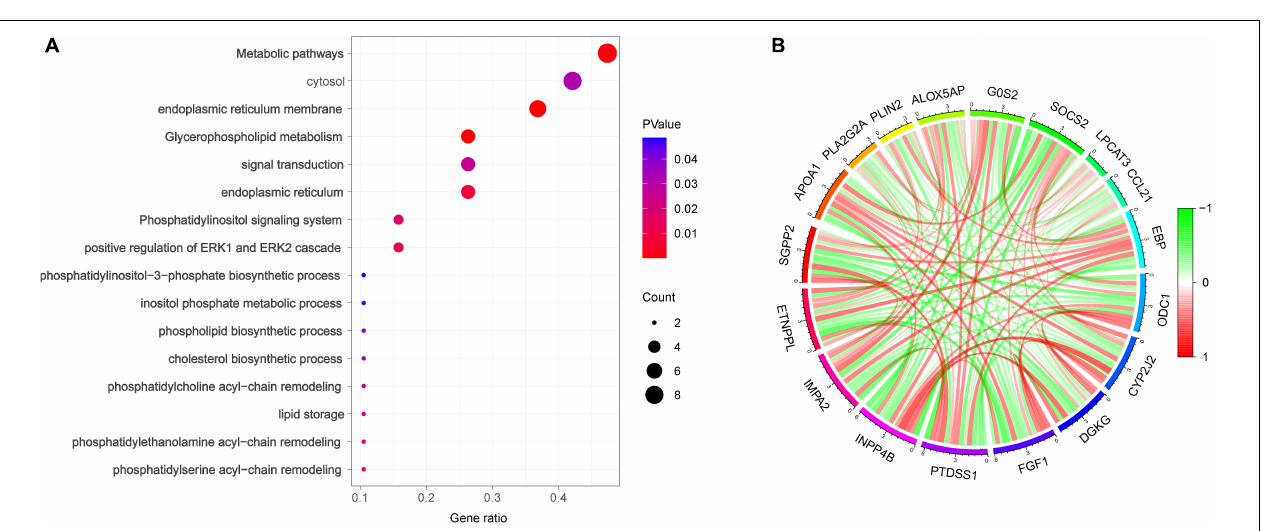
FIGURE 2 | Identification of differentially expressed lipid metabolism-related genes (DELs) in DCM and healthy samples. (A) Histogram of the enrichment of Gene set variation analysis (GSVA). (B) Heatmap of the top 40 differentially expressed genes (DGEs) in the integrated microarray dataset. (C) Volcano plot of the 222 DGEs. The red dots represent the significantly up-regulated genes and the blue dots indicate the significantly down-regulated genes. (D) The boxplot of 18 differentially expressed lipid metabolism-related genes in the integrated microarray dataset.